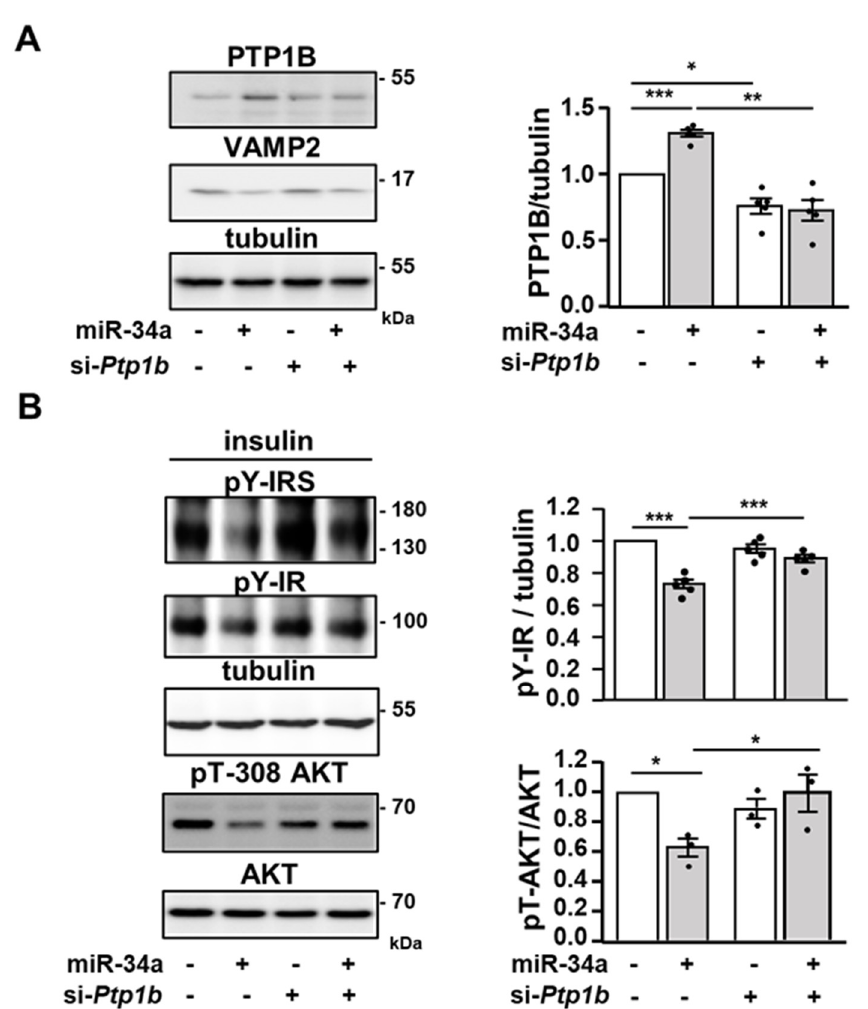
Figure 5. miR-34a inhibits insulin signaling by increasing PTP1B expression: ( A ) Representative immunoblot ( left panel) of the expression of PTP1B, VAMP2, and tubulin as loading control in 3T3-L1 adipocytes transfected with a control miRNA or a miR-34a mimic in combination with a siRNA against Ptp1b or a control siRNA. Bar graph ( right panel) represents mean values ± SEM of the densitometry analysis for the PTP1B/tubulin ratio from five independent experiments. ( B ) Representative immunoblot ( left panel) of the level of tyrosine phosphorylation (pY) of IR and IRS, phosphorylation of AKT on threonine 308 (pT-308 AKT), and expression of total AKT and tubulin (loading control) in 3T3-L1 adipocytes transfected as in ( A ) and treated with insulin (0.5 nM) for 10 min. Bar graphs ( right panel) represent the densitometry analysis for the pY-IR/tubulin and pT-308 AKT/AKT ratio. Data are mean values ± SEM of 3–5 independent experiments. * p < 0.05, ** p < 0.01 and *** p < 0.001.